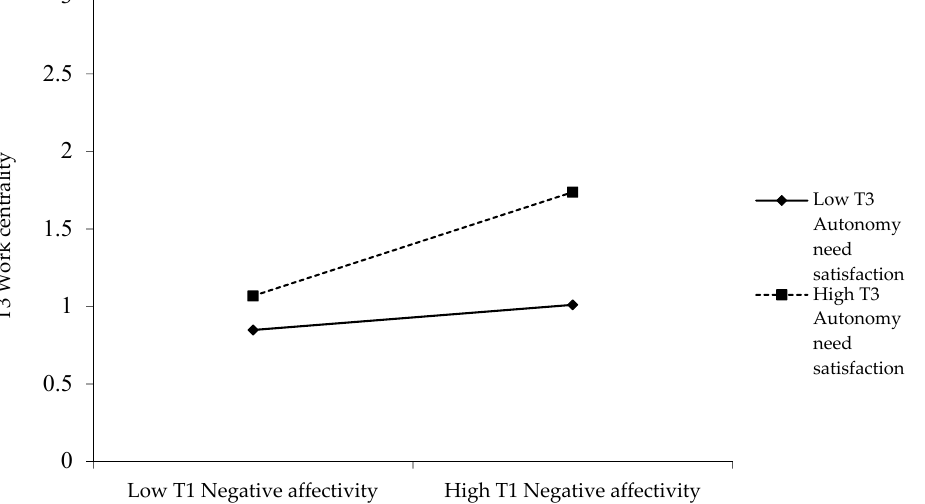
Figure 1. Interaction between Time 1 Negative Affectivity and Time 3 Autonomy Need Satisfaction predicting Time 3 Work Centrality.